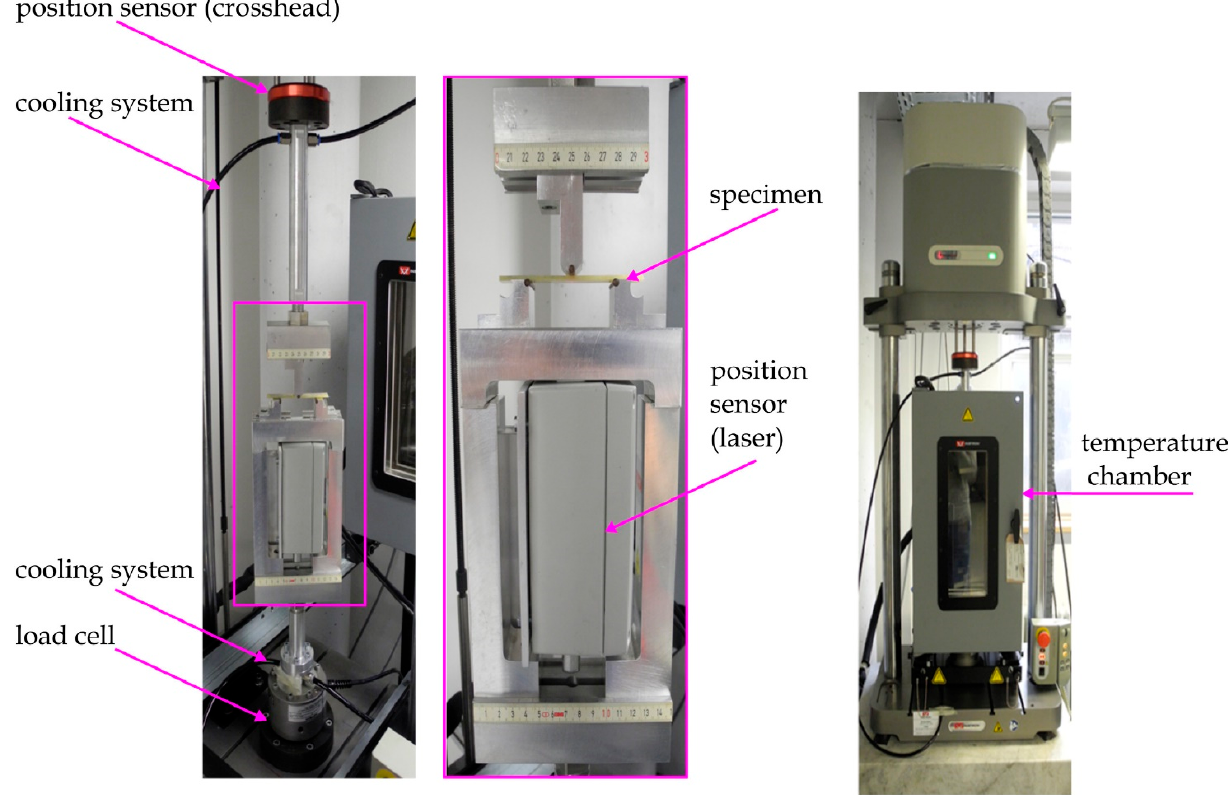
Figure 55. The experimental setup for characterizing DMTA using a water-based coolant system [169].